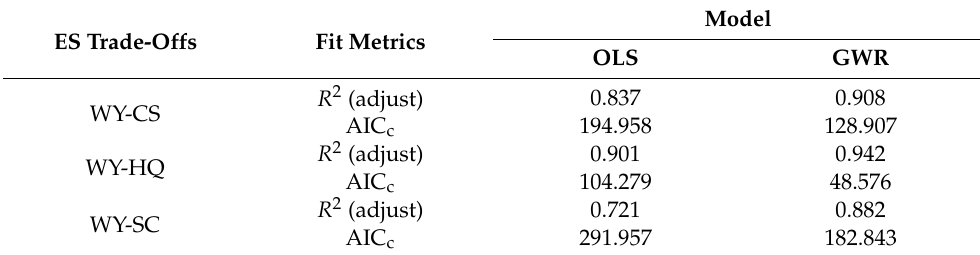
Table 5. Model fit metrics for ordinary least squares (OLS) regression and GWR.